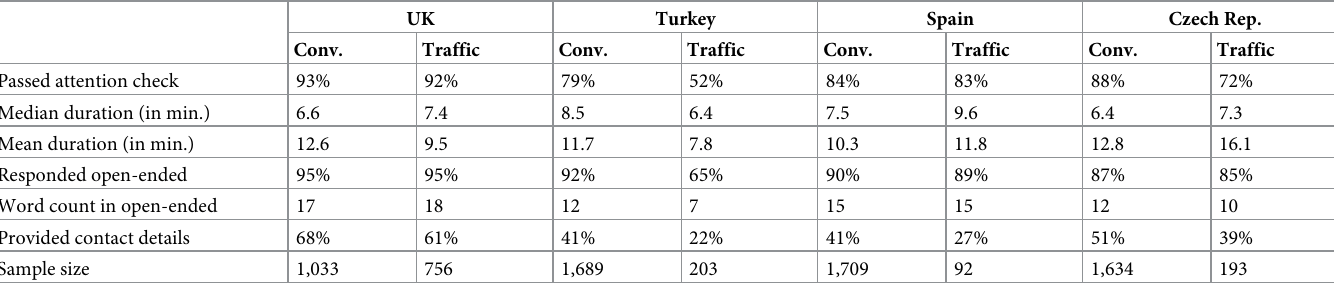
Table 4. Comparison of response quality for campaign objectives for survey completers.